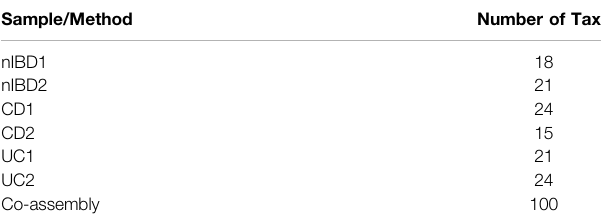
TABLE 3 | Number of SGB taxonomies retrieved per